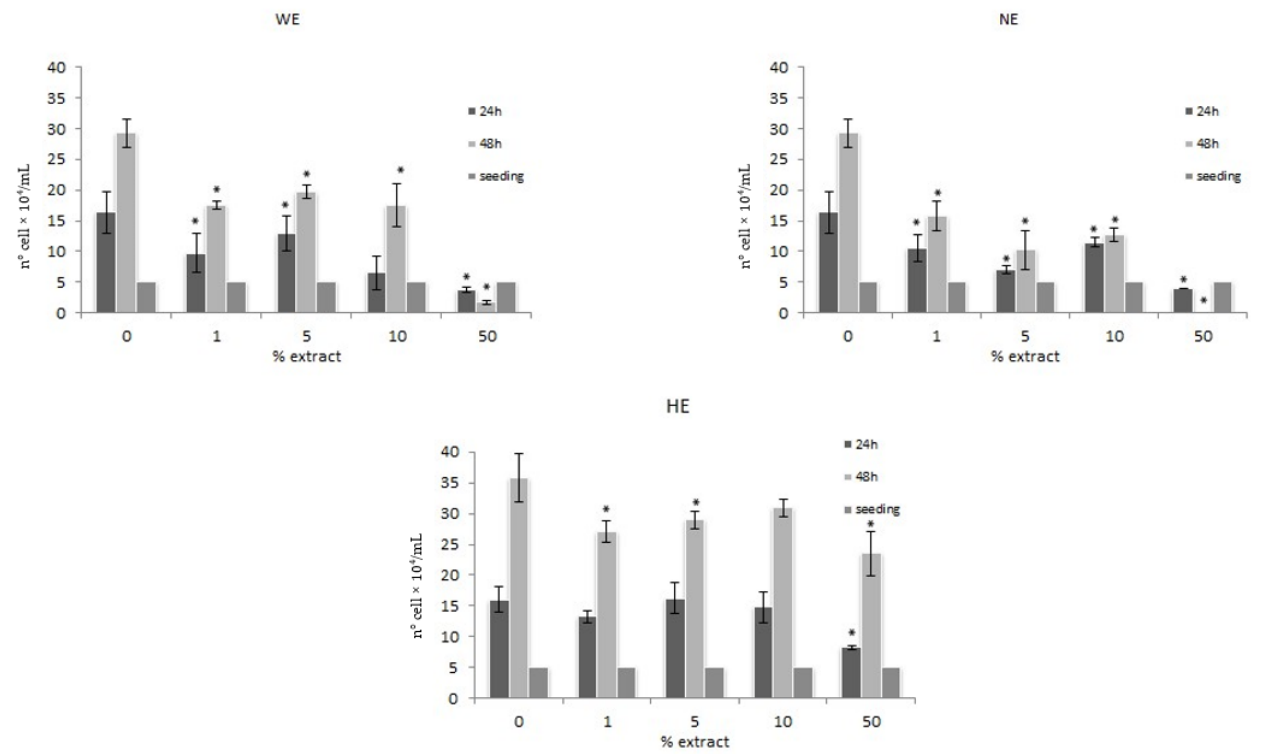
Figure 2. Modulation of the proliferation of HT29 cell line: number of cells/mL after 24 (dark grey) and 48 (light grey) hours of treatment with increasing concentrations of spinach extract. WE = water extract, NE = liquid nitrogen extract, HE = hydrophilic extract (* p < 0.05 taking into account the growth at 0 concentration). Seeding is the number of cells at time 0.